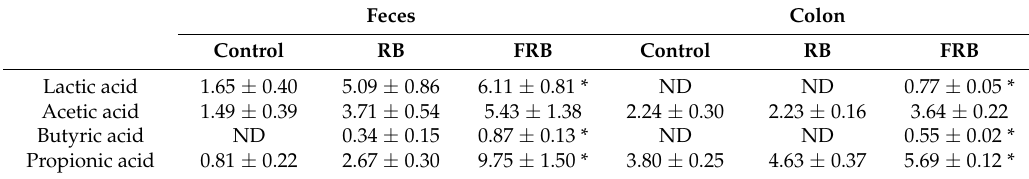
Table 2. Concentration of short-chain fatty acids (SCFAs; μ mol/g) in the feces and colon tissue. Feces Colon Control RB FRB Control RB FRB Lactic acid